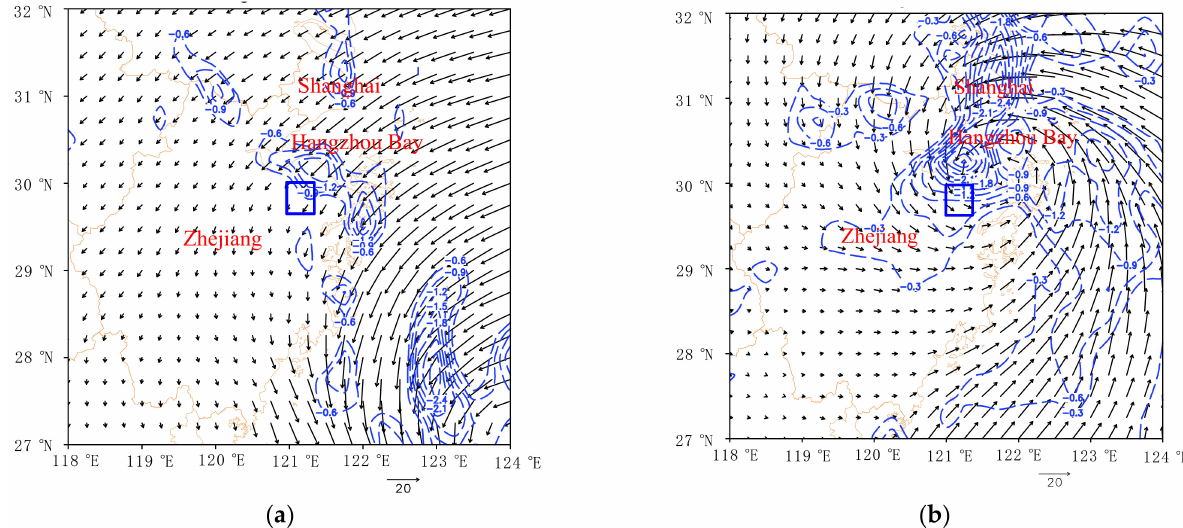
Figure 11. Surface wind (arrow) and divergence (blue dashed line, unit: 10 − 6 s − 1 ) at ( a ) 1400 BT on July 24, 2021, and ( b ) 2000 BT on July 25, 2021. The blue frame indicates the area of Siming Mountain.